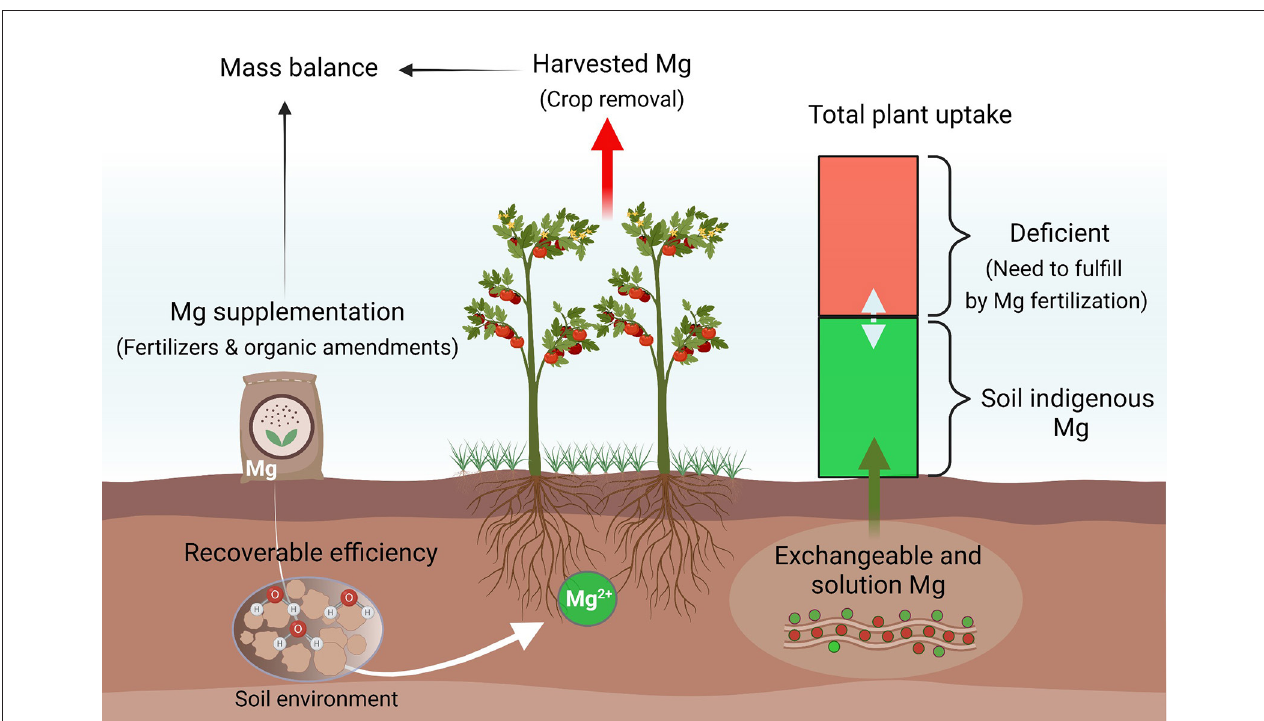
FIGURE 7 | A proposed model to combat rising Mg deficiency in different agroecosystems. Mg availability to plants highly depends on the abundance of indigenous Mg and other soil factors. To close yield gaps in different croplands, Mg recommendations should be optimized primarily according to its net removal and indigenous soil